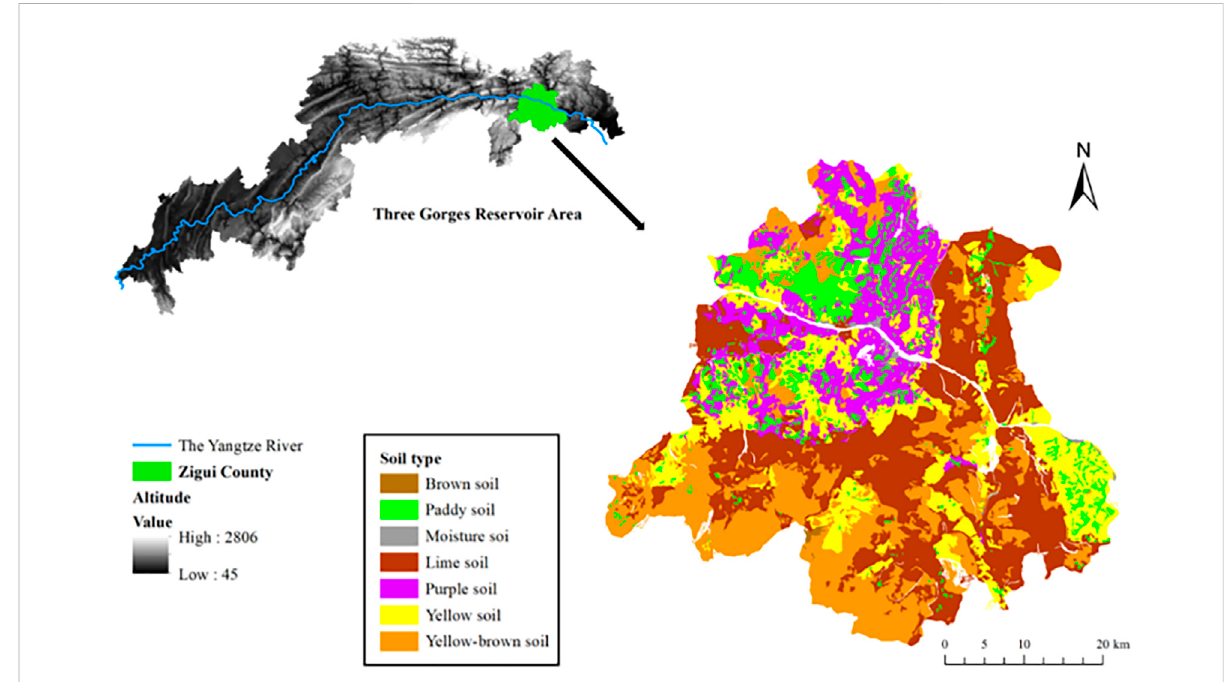
FIGURE 1 Geographical location and soil type of Zigui country in the Three Gorges Reservoir area.